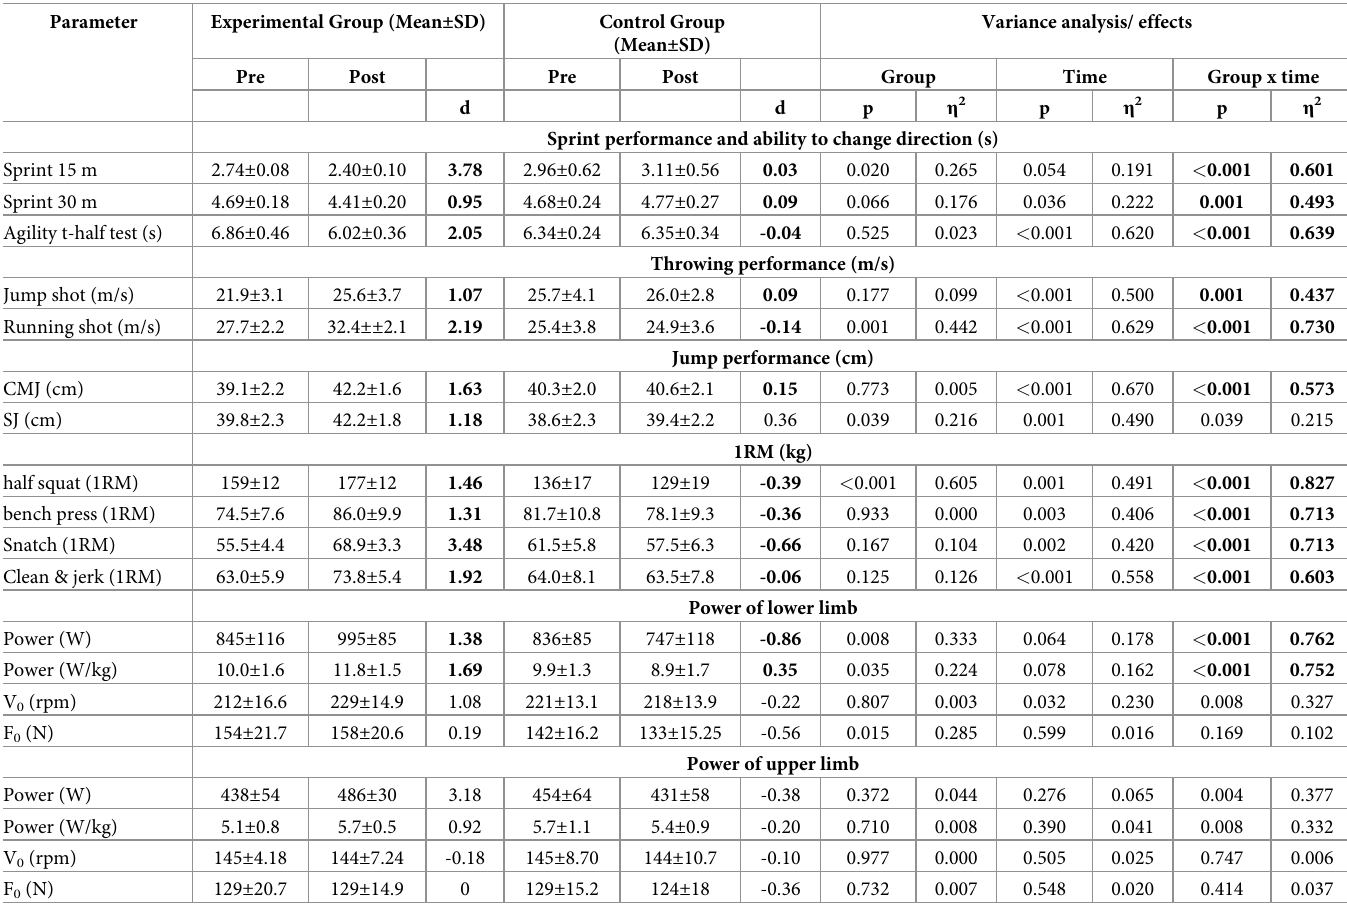
Table 2. Comparison between the experimental and control groups before and after 10-week training period (examination 1 vs. 2). Significant interaction effects and effect sizes are highlighted in bold.